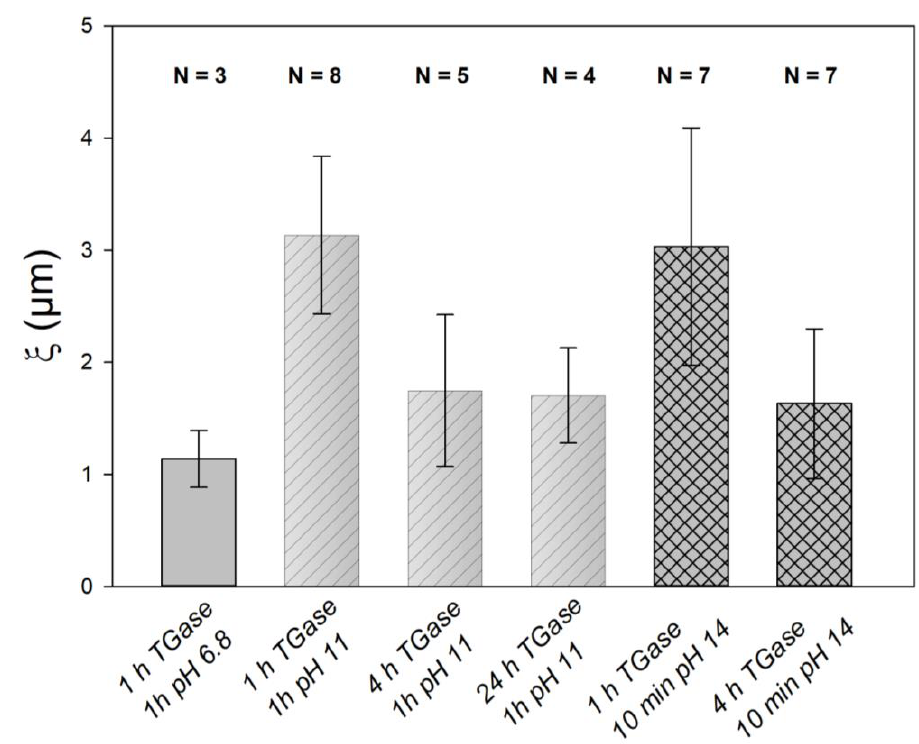
Figure 7. Characteristic distances of the microstructure of CMPs at different pH values and different TGase treatment times (1, 4 & 24 h) obtained by spatial correlation analysis of the gray values of line cuts through microscopic images. The error bars correspond to the standard deviation.